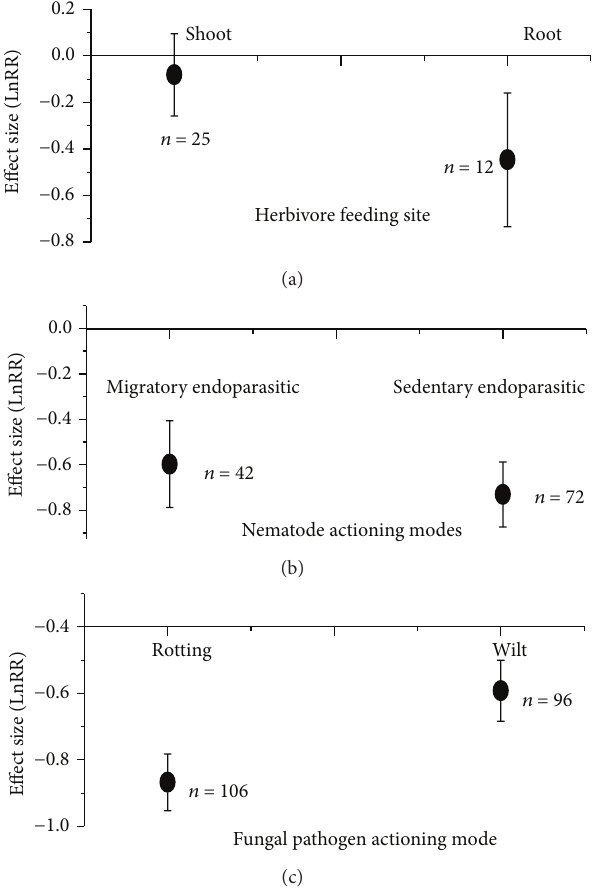
Figure 5: Effect size ( mean ± 95 % CI ) of AMF to biotic stressors of plants: (a) herbivores; (b) nematodes; (c) fungal